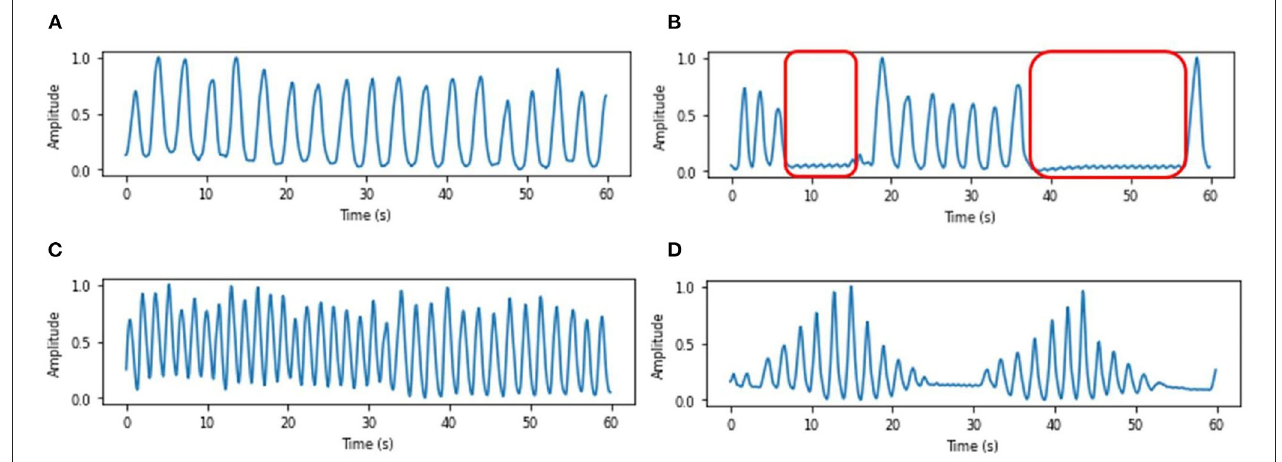
FIGURE 6 | Respiration belt samples of typical respiratory patterns, (A) Eupnea, (B) Apnea, where red boxes represent the apnea events, (C) Kussmaul respiration, and (D) Cheyne Stokes respiration.